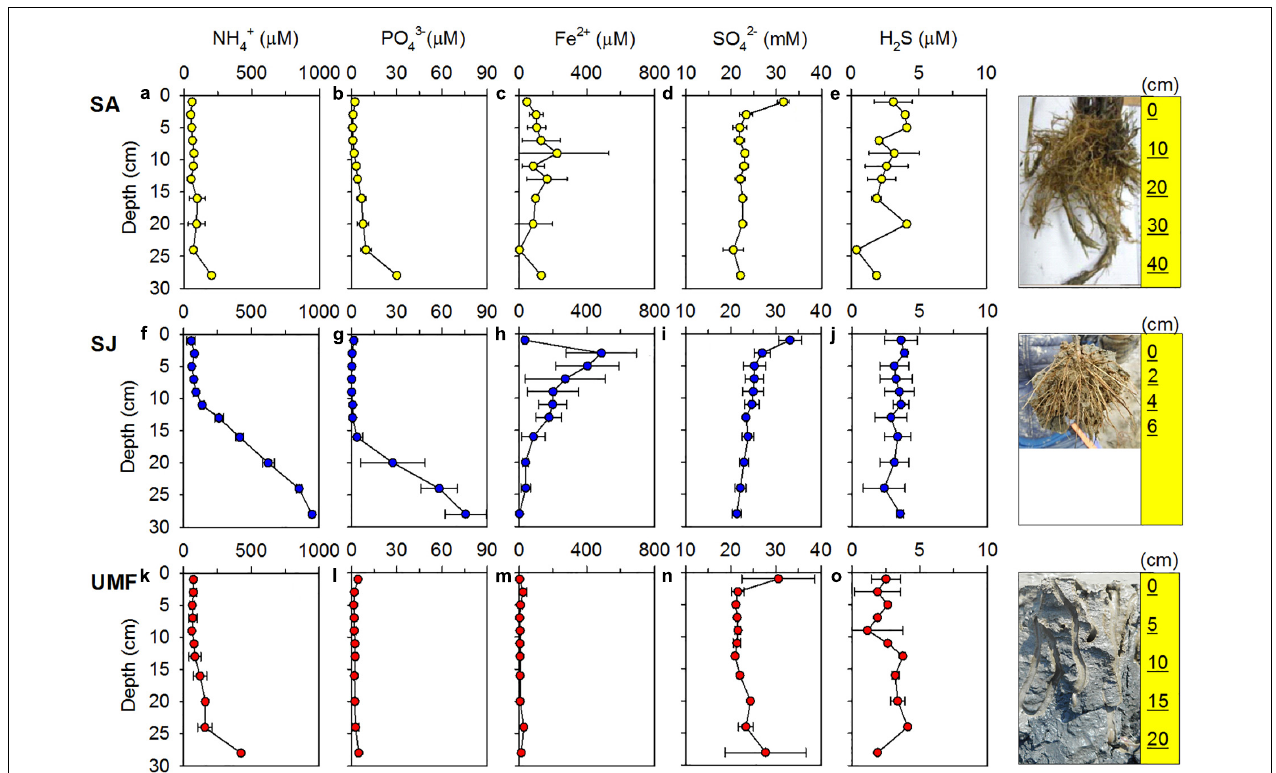
FIGURE 2 | Vertical profiles of NH 4 + (a,f,k) , PO 43 − (b,g,l) , Fe 2 + (c,h,m) , SO 42 − (d,i,n) , and H 2 S (e,j,o) in the pore water at the Spartina anglica (SA), Suaeda japonica (SJ) sites and the unvegetated mud flat (UMF) site. Error bars indicate a mean ± 1 SD from duplicate or triplicate cores. The rightmost figures indicate the size of root systems of S. anglica and S. japonica , and the burrows formed by macrofauna in the UMF